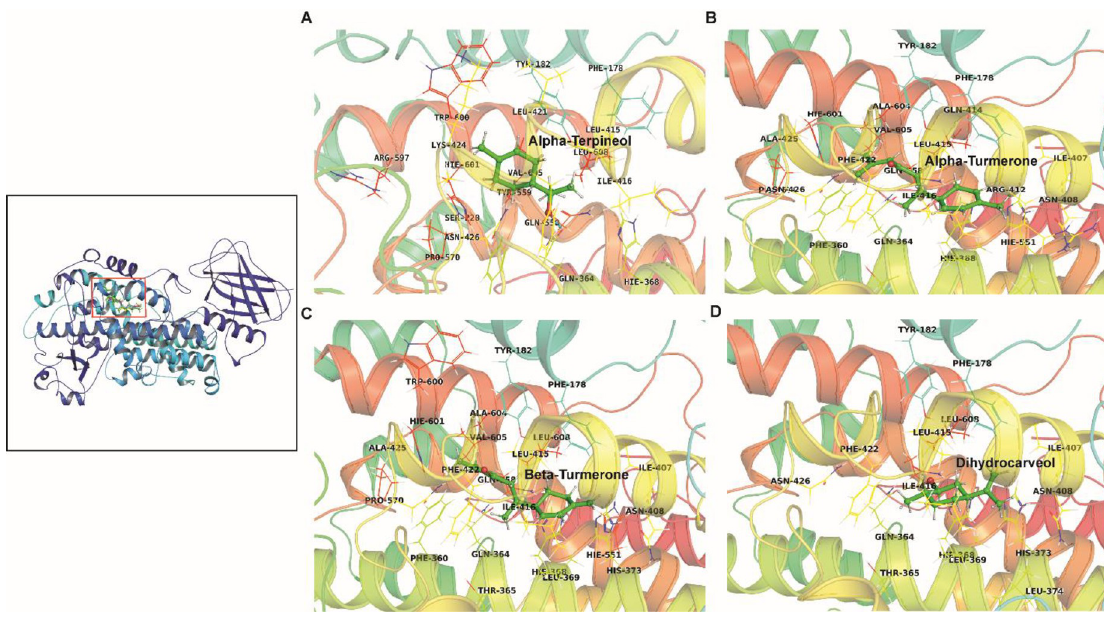
Fig 1. Intermolecular contact analysis of the top four-ligands (A: B: C: D:) with 5-LOX protein obtained from docking using Glide displaying various non-bonded contacts. The image was rendered using PyMOL. The hydrogen bonds are shown in dotted lines. The left panel displays the structurally superimposed view of the top ranked 5-LOX-ligand complexes obtained from docking.